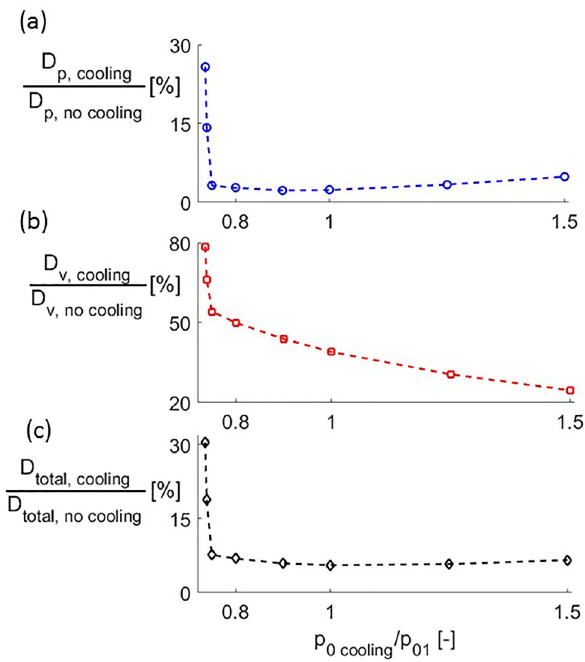
Figure 10. ( a ) Pressure, ( b ) viscous and ( c ) total drag reduction under cooling injection